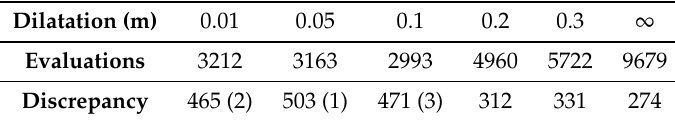
Table 3. “Wax” geometrical constraint experiment